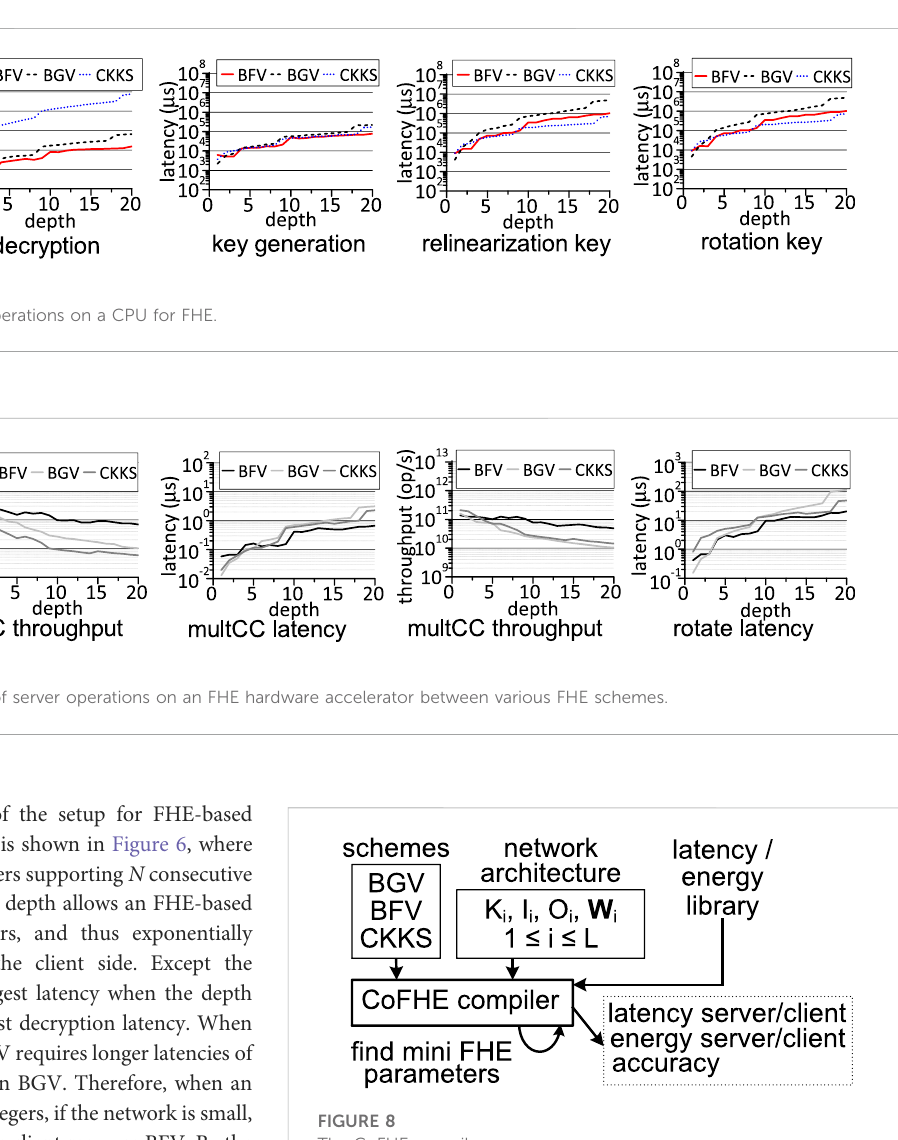
FIGURE 8 The CoFHE